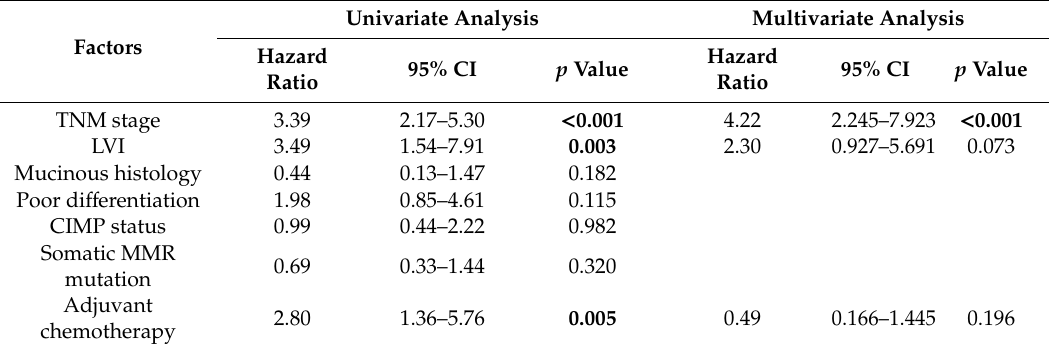
Table 5. Univariate and multivariate analysis of factors a ff ecting overall survival (OS) of CRC patients.